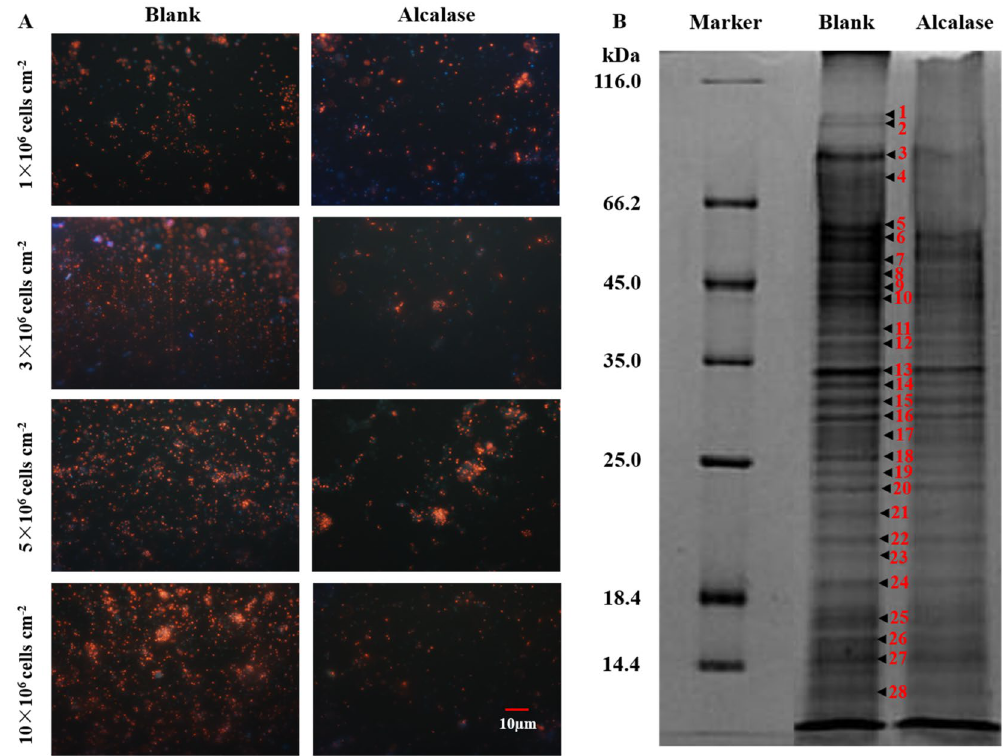
Figure 5. The images of S. marisflavi biofilms ( A ) under BX51 and biofilm bacterial proteins by SDS-page ( B ) treated by